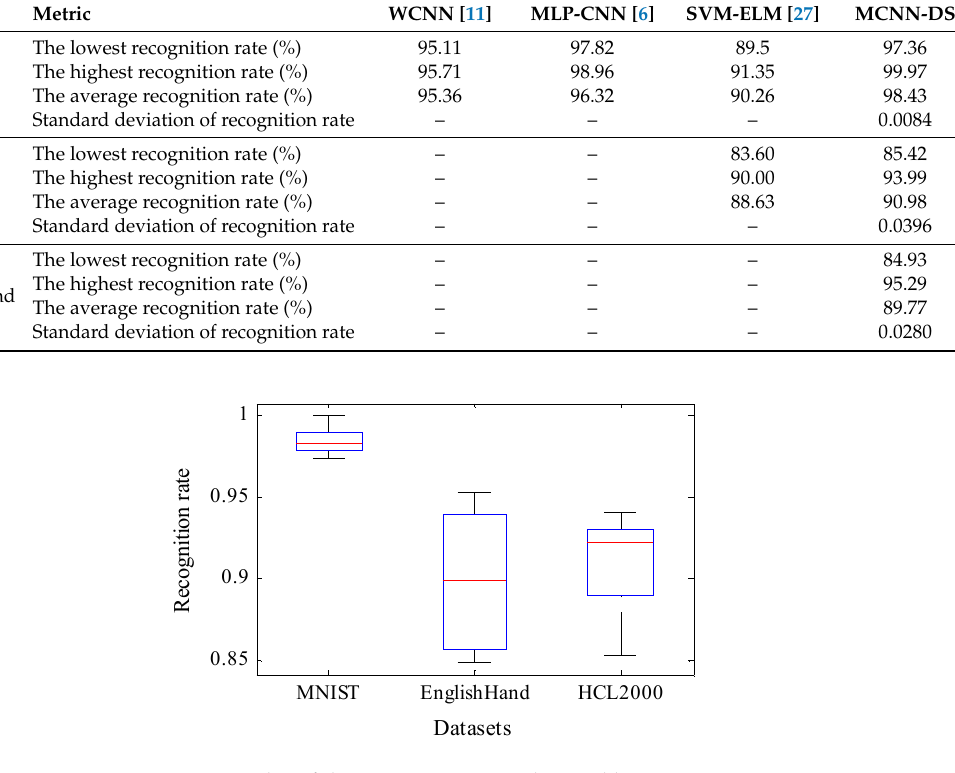
Figure 10. Boxplot of the recognition rate obtained by MCNN-DS. Table 3. Statistic results of time